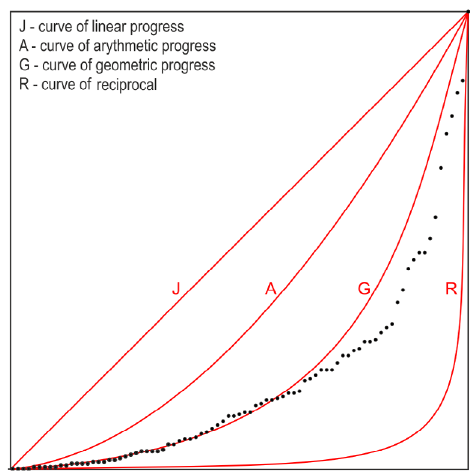
Fig. 6. Curves used to determine the